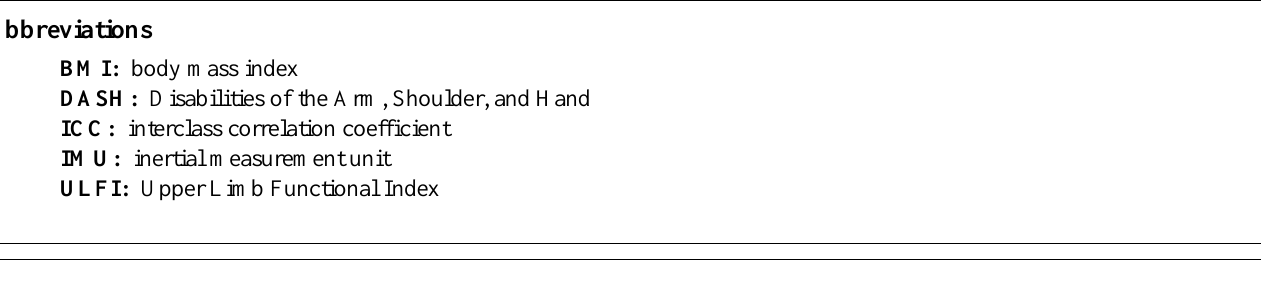
shoulders. Part II: review of 3-D scapular kinematic patterns in patients with shoulder pain, and clinical implications. Ann Phys Rehabil Med 2018 Jan;61(1):46-53 [FREE Full text] [doi: 10.1016/j.rehab.2017.09.002] [Medline: